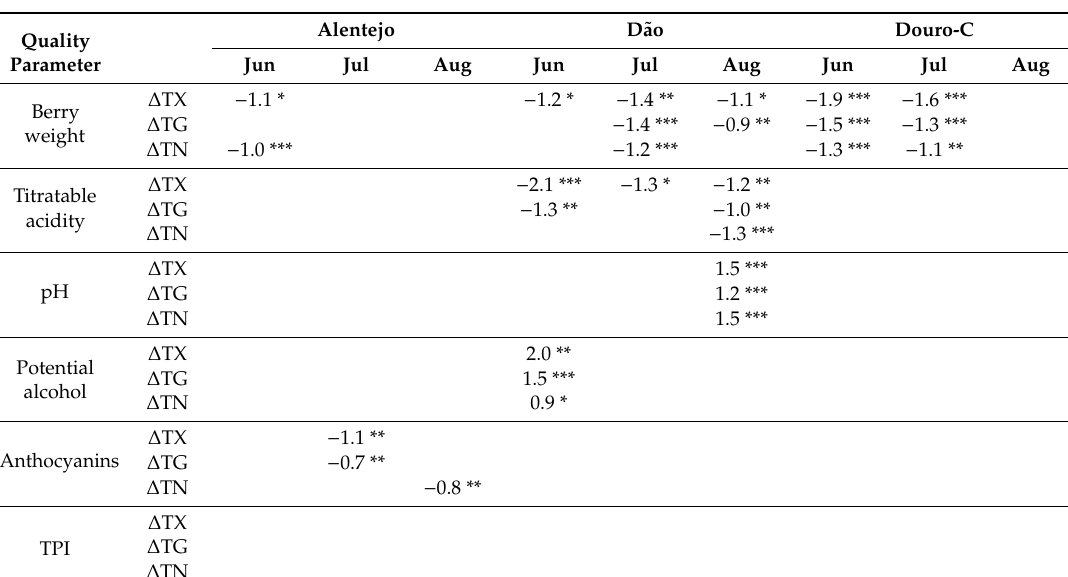
Table 5. Di ff erence (in ◦ C) between the clusters for monthly means of TX, TG and TN in June, July